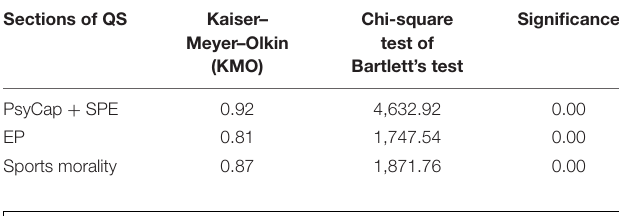
TABLE 6 | Questionnaire Survey validity analysis.